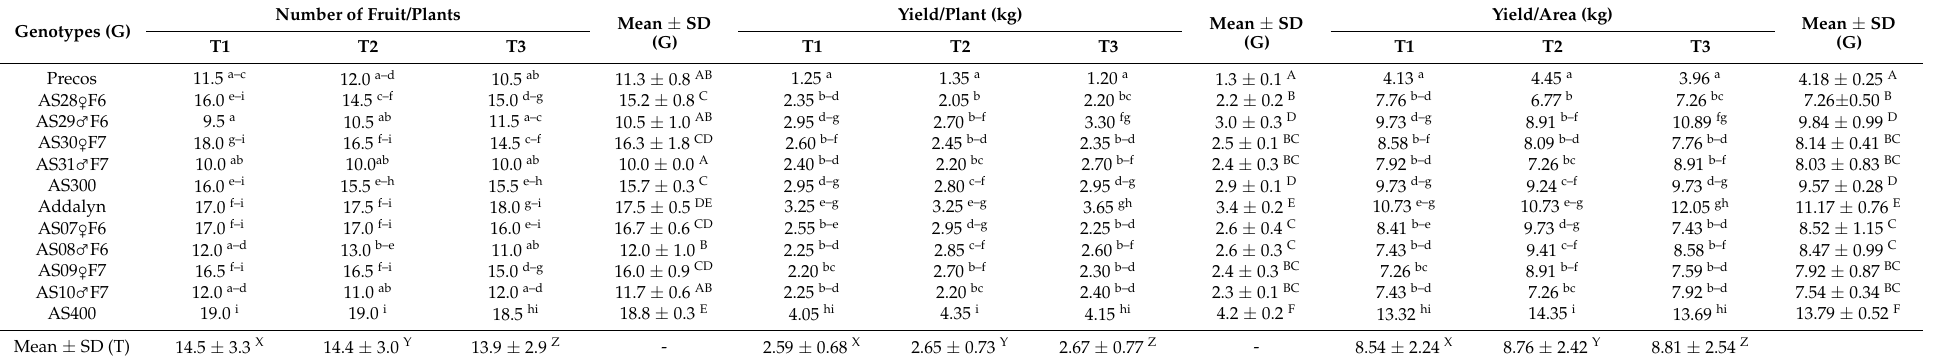
Table 6. The main quantitative parameters of tomato production according to genotype and